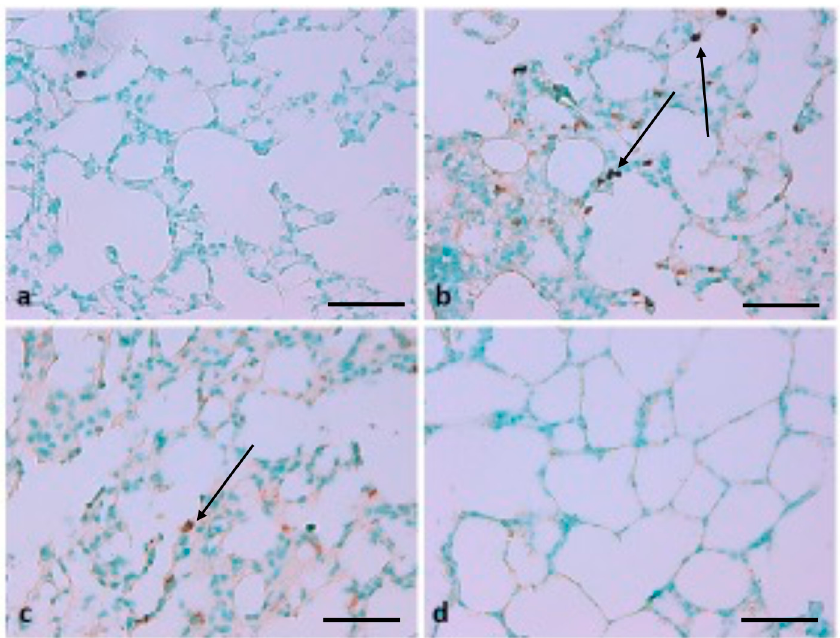
Figure 10. Effect of TQ on terminal deoxynucleotidyl transferase-mediated dUTP nick end labelling (TUNEL)-positive cells. ( a ) Brown-stained nuclei were not noticed in the control group; ( b ) large numbers of positive cells were stained brown in the B(a)P-induced lung injury group, the arrow indicates brown stained nuclei ( c ) the group treated with TQ plus B(a)P showed a significantly decreased apoptosis rate, the arrow indicates brown stained nuclei ( d ): the group treated with only TQ did not show any signs of apoptosis. (Scale bar = 100 μ m.)